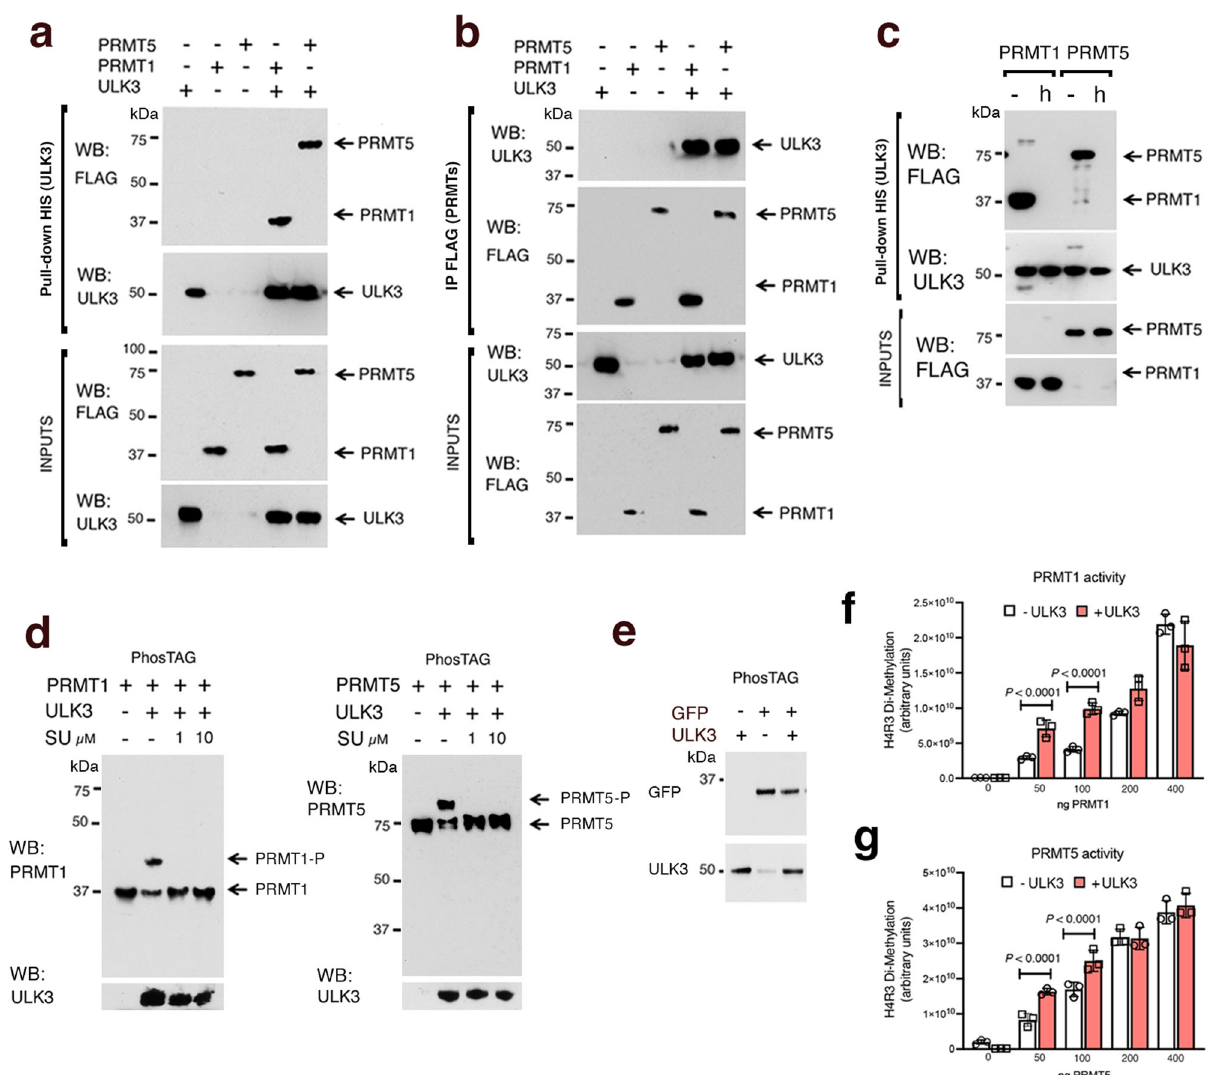
Fig. 7 | ULK3 binds directly to PRMT1 and PRMT5 and controls their activity. a Immunoblot analysis of recombinant FLAG-tagged -PRMT1 (200ng) or -PRMT5 (200ng) admixed with His-tagged ULK3 (200ng) and pulled-down with a Ni-NTA resin(NTA).Thesameamountsofproteinswereincubatedwiththeresinsingularly as controls. Sequential FLAG and ULK3 immunoblots. b Recombinant PRMT1 and